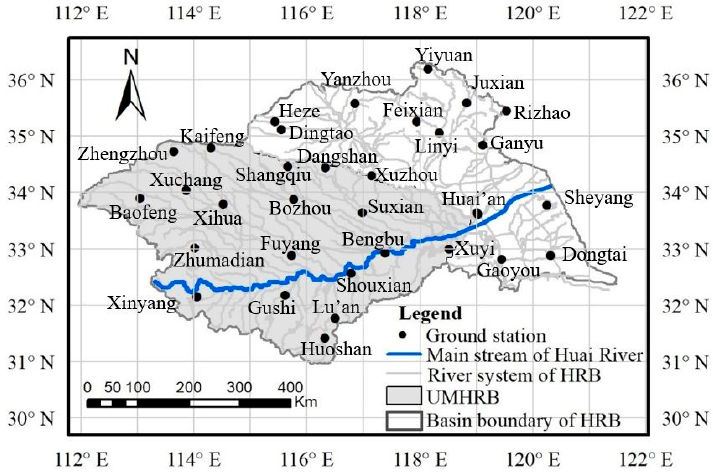
Figure 1. Location of the upper and middle reaches of the Huai River Basin (HRB) (UMHRB) and the distribution of ground meteorological